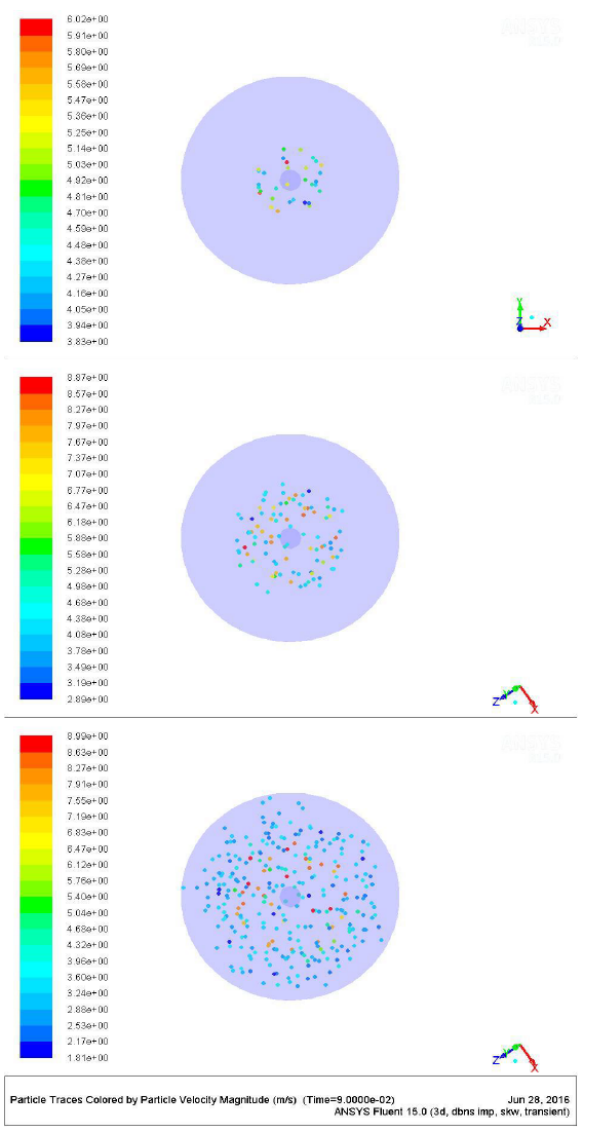
Figure 8. Design of the spread process on ANSYS Fluent